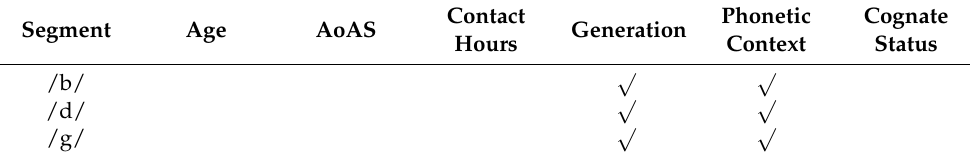
Table 2. Summary of significant effects on lenition of /bdg/.